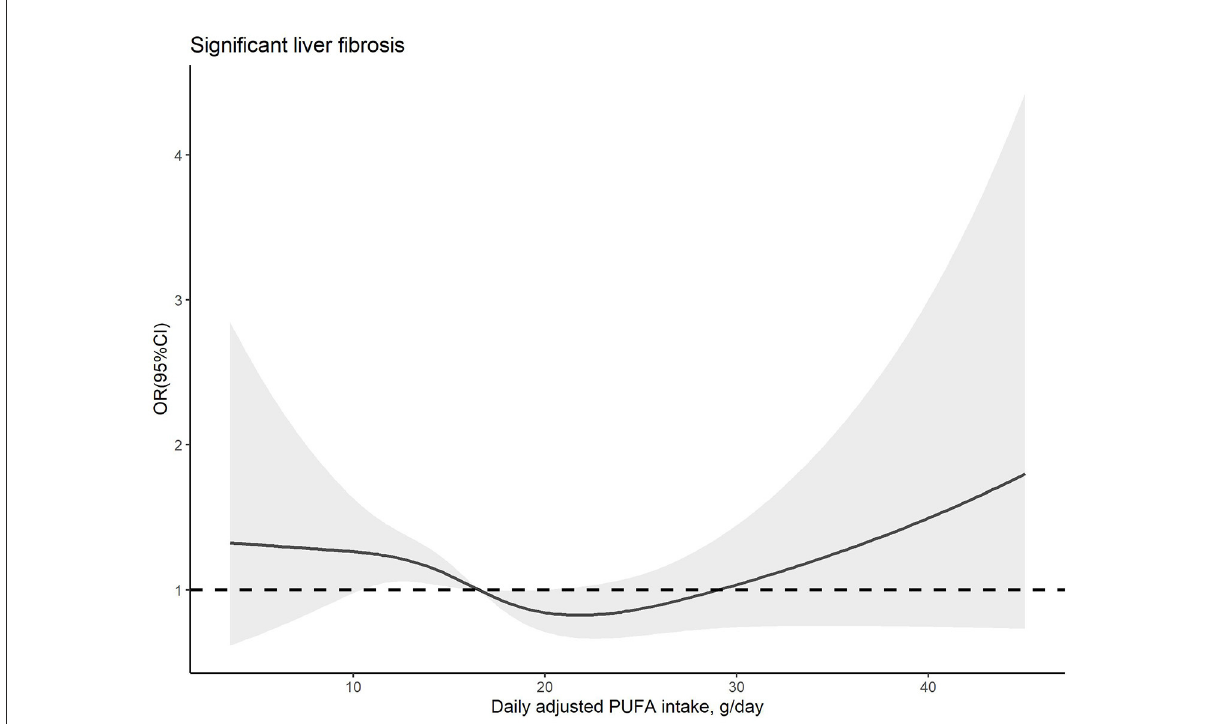
FIGURE2 Dose–response relationship between dietary PUFA intake and significant liver fibrosis. The solid line and shadow area represent the estimated odds ratios (ORs) and their corresponding 95% confidence intervals (CIs). The adjusted variables were the same as those in model 2, including age, sex, family income-to-poverty ratio, education level, marital status, ethnicity, platelet count, ALT, AST, GGT, ALP, albumin, total bilirubin, pre-hypertension, hypertension, diabetes, prediabetes, CVD, history of cancer, dyslipidemia, use of oral corticosteroid over 180 days,